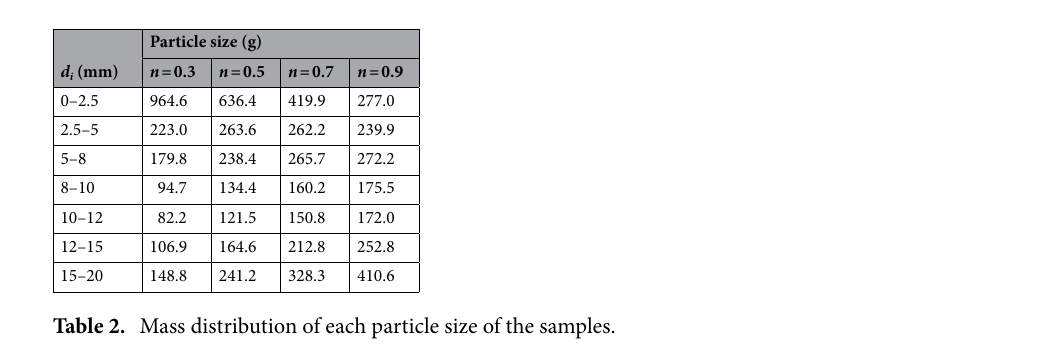
Table 2. Mass distribution of each particle size of the